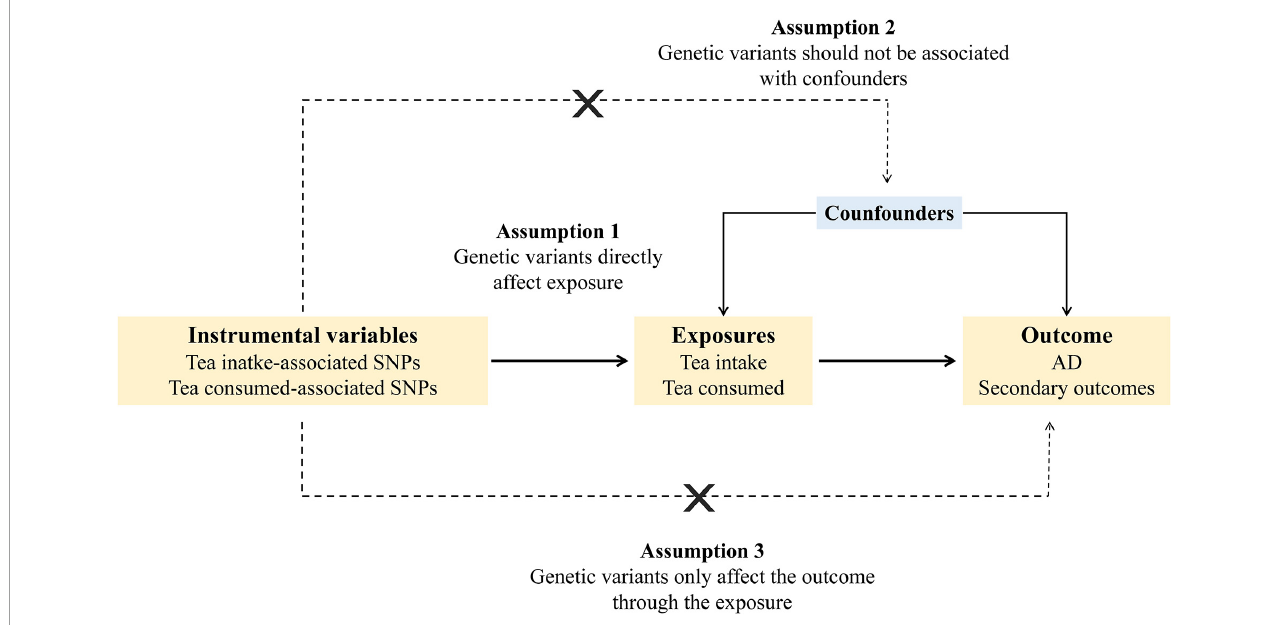
FIGURE1 Schematic diagram of the Mendelian randomization assumptions. AD, Alzheimer’s